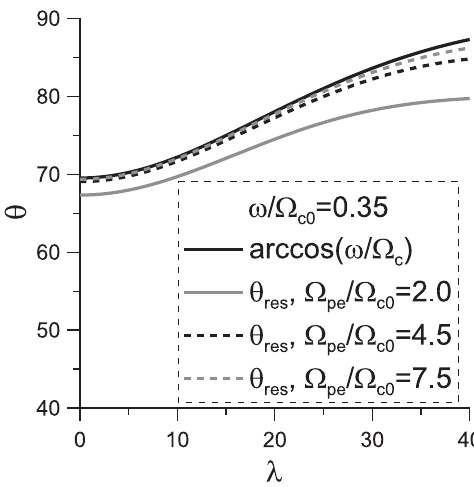
Fig. 4. Resonance cone angle as a function of latitude. The approx- imate value θ r = arccos (ω m /(cid:127) c ) from the simplified dispersion re- lation (solid black line) is compared with exact solutions obtained with the Appleton–Hartree dispersion for different ratios (cid:127) pe /(cid:127) c0